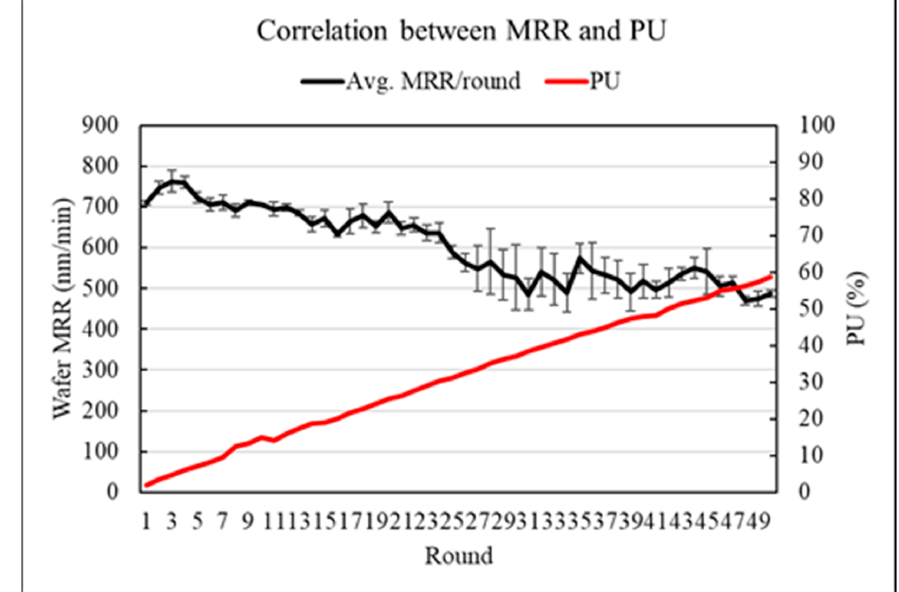
Figure 14. The correlations between MRR and PU.